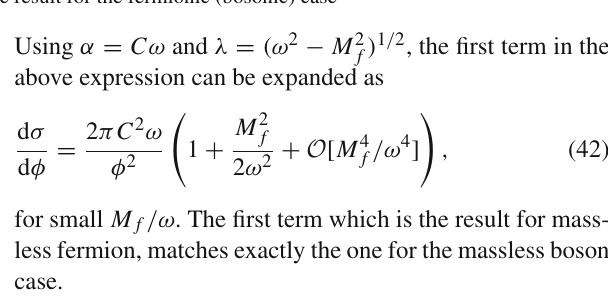
Fig. 2 d σ as a function of ω M − 1 for two different values φ = π/ 5 ( left panel ) and φ = π/ 100 ( right panel ). The graphs are plotted for d φ C = 0 . 01 M − 1 , D = 0 and M f = 0. The solid ( dashed ) line represents the result for the fermionic (bosonic)